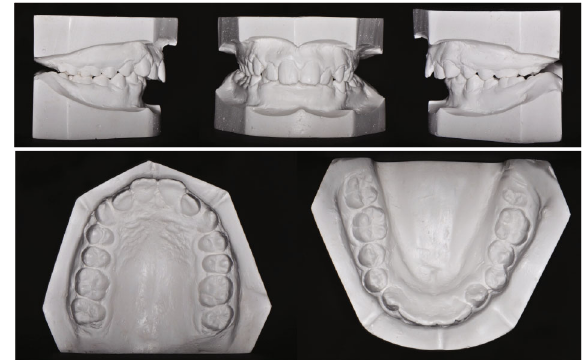
Figure 2: Pretreatment orthodontic study models.